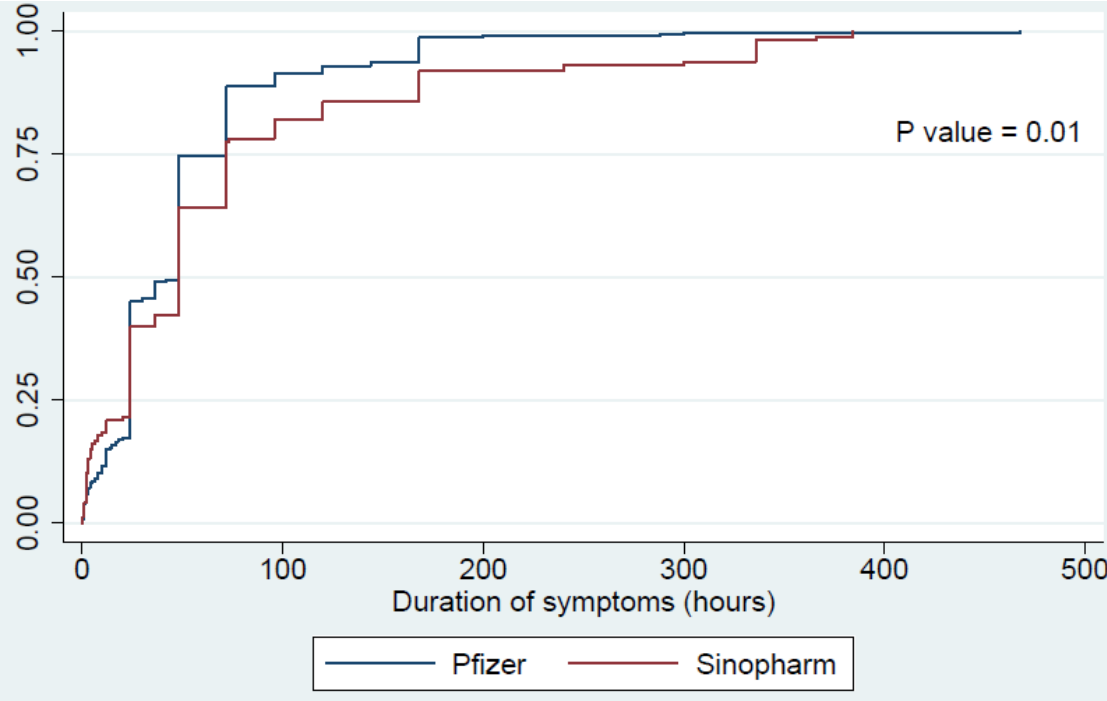
Figure 2. Improvement time of the adverse reactions following the second dose of the vaccine.